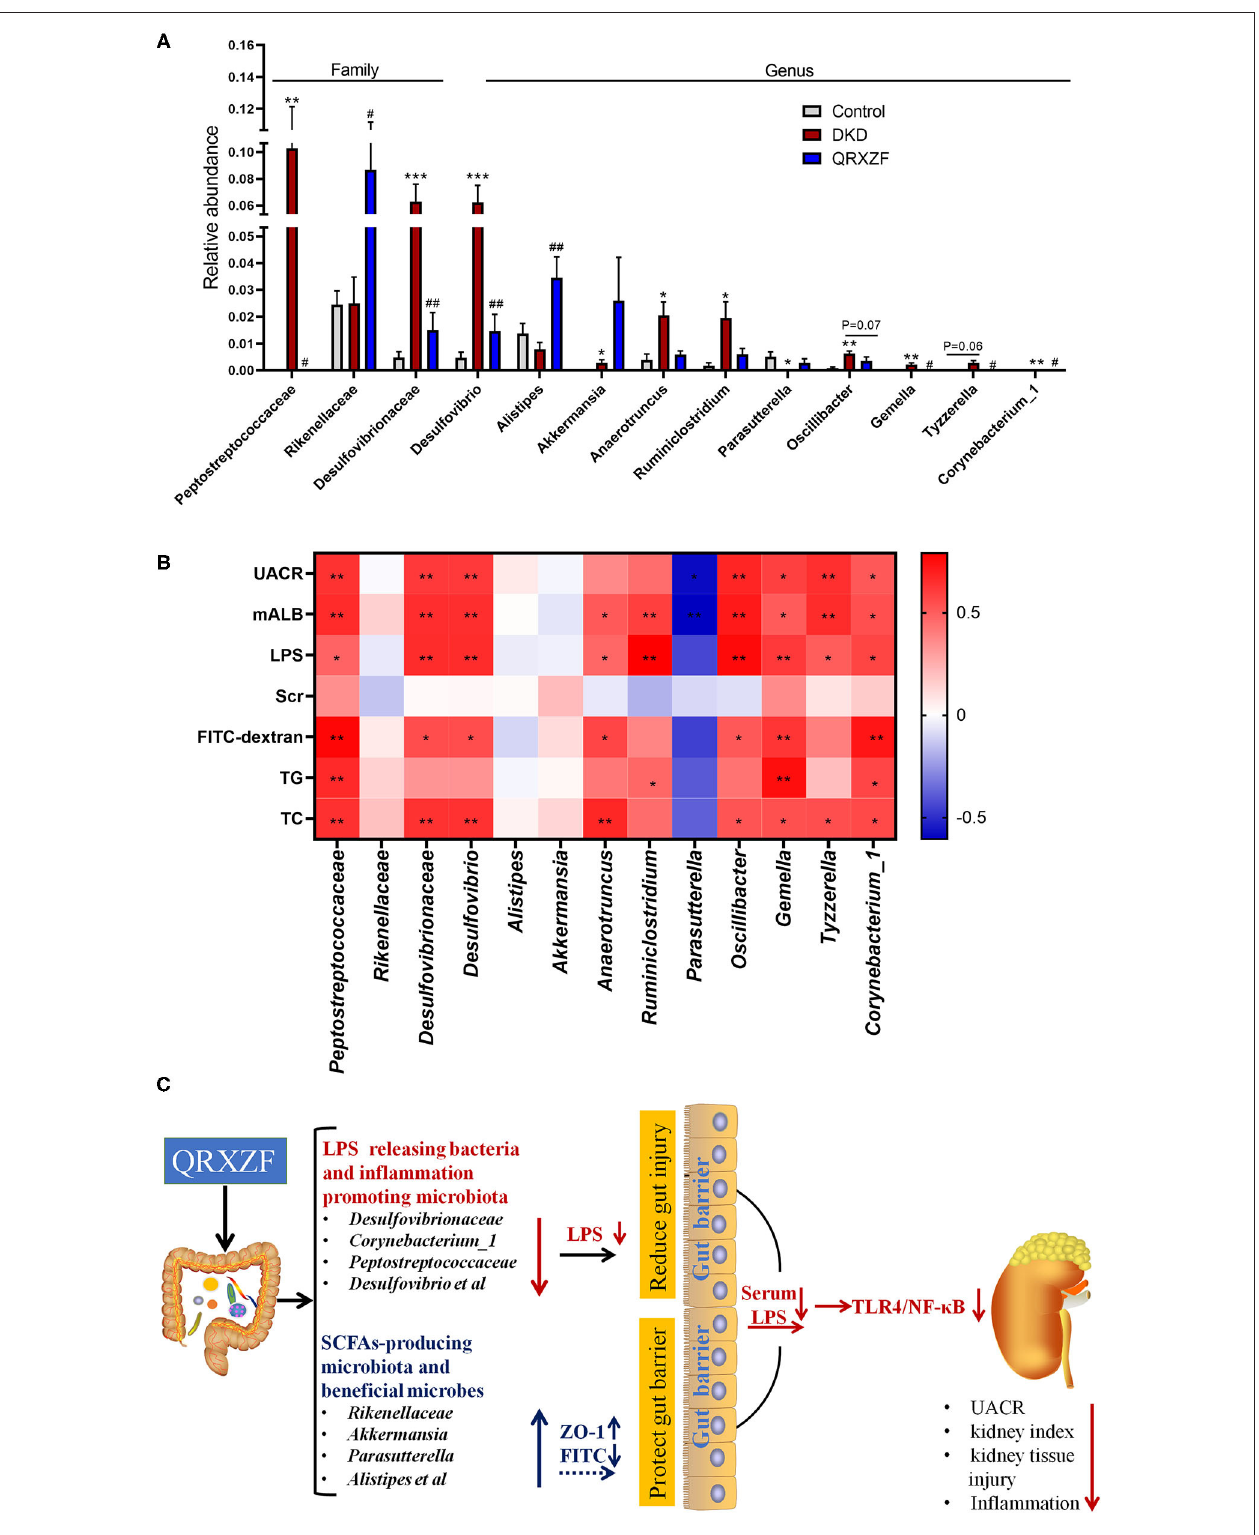
FIGURE 6 | (A) Relative abundance at the family and genus level ( n = 6, means ± SEM); (B) Correlation analyses between metabolic parameters and relative abundance of gut microbiota at family and genus level; (C) The mechanisms schematic of action of QRXZF in High-fat diet (HFD) and streptozotocin